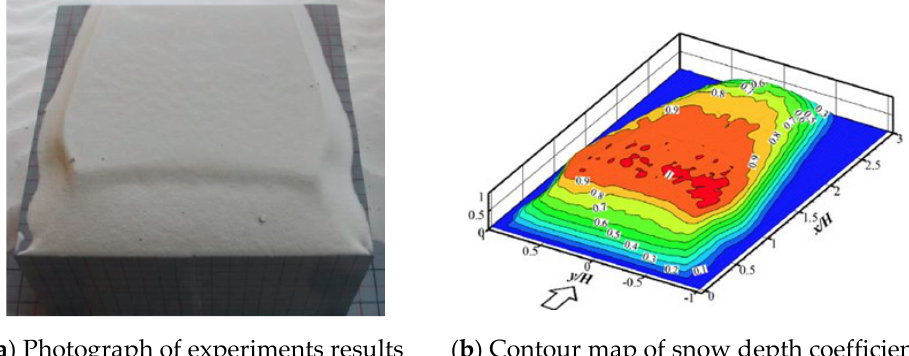
Figure 1. Photograph of typical experiment results and distribution of snow depth coefficient [23].